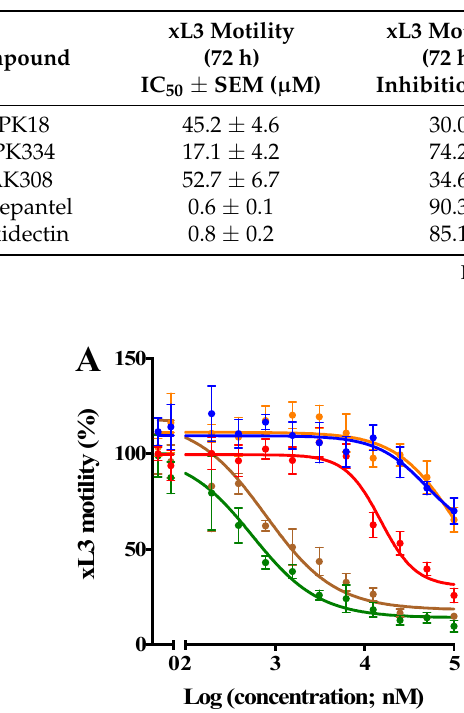
Table 1. In vitro-activities of three hit compounds (MPK18, MPK334 and YAK308) against exsheathed third-stage larvae (xL3) of Haemonchus contortus . Half maximal inhibitory concentration (IC 50 ) values of each compound on the larval motility after 72 h incubation and the larval development into fourth-stage larvae (L4) after seven days are presented in reference to the values of two control compounds (monepantel and moxidectin) obtained in the same assay condition. Half cytotoxic concentration (CC 50 ) values against HepG2 human hepatoma at 48 h are presented for five test and control compounds. The selectivity indices (SI) were calculated for five compounds based on their IC 50 and CC 50 values. The IC 50 values presented are the mean ± standard error of the mean (SEM). Three independent experiments were conducted in triplicates.